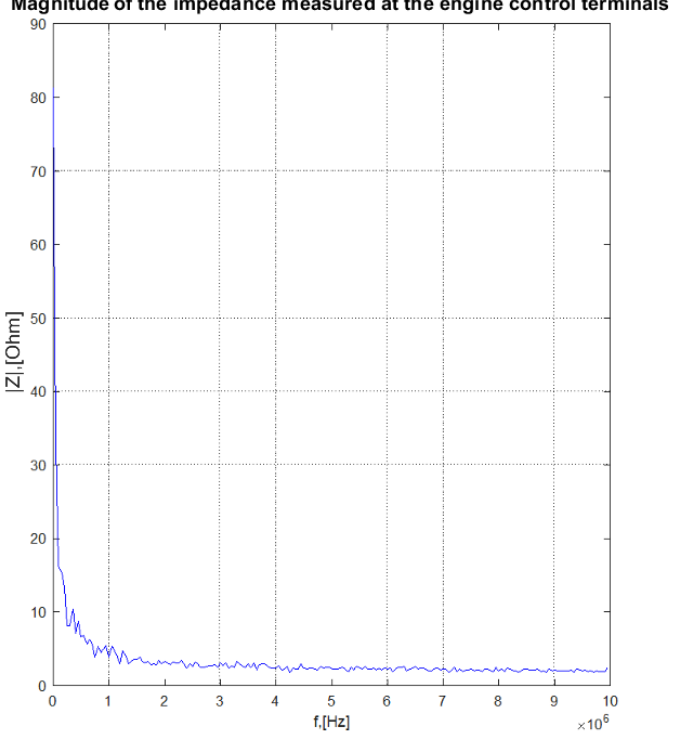
Figure 16. Linear characteristics of the impedance of the engine control terminals side as a function of frequency.